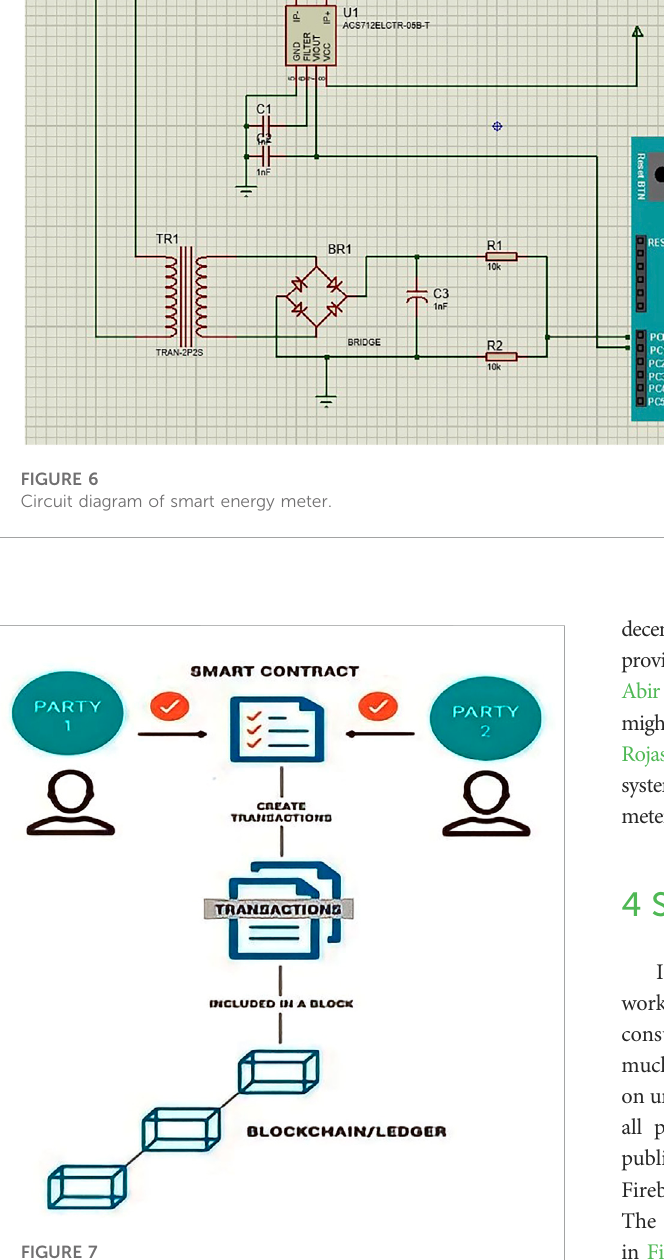
FIGURE 7 Flow diagram of blockchain and smart